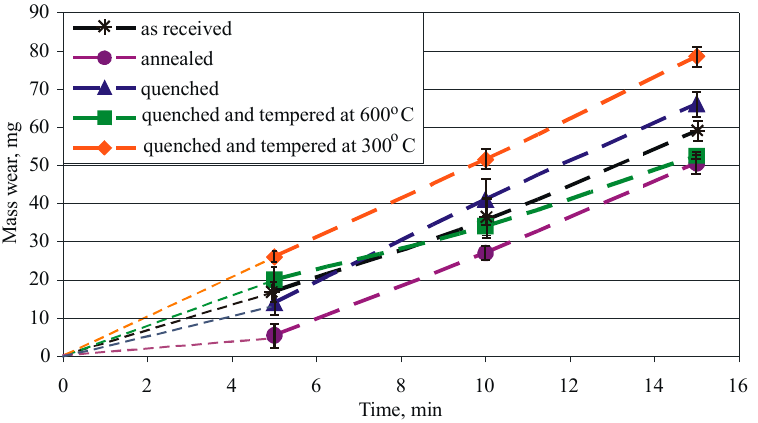
Figure 16. Mass wear: 1—as received, 2—annealed, 3—quenched, 4—quenched and tempered at 600 °C, 5—quenched and tempered at 300 °C.